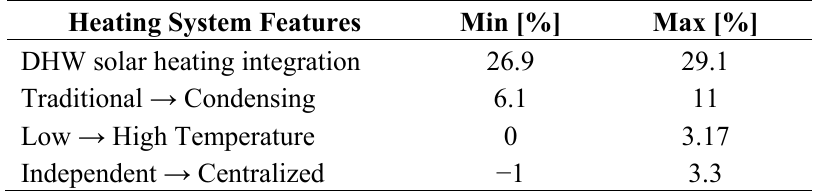
Table 6. Reduction of primary energy consumption due to heating system features.